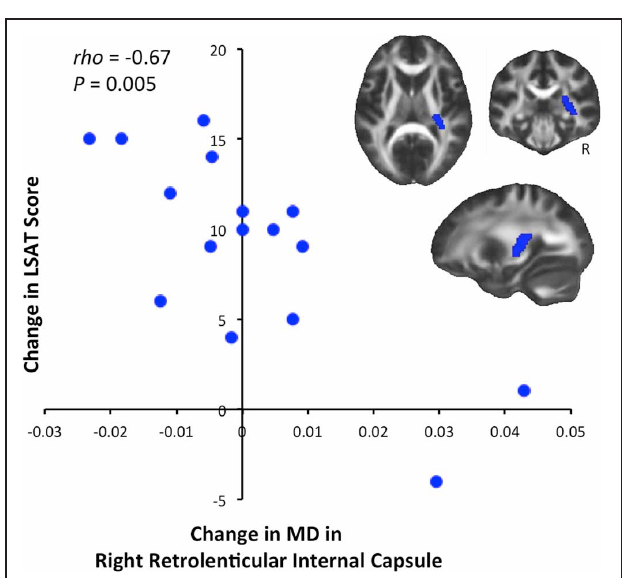
FIGURE 2 | Distribution of diffusion mode for whole-brain results. Histograms showing percentage of voxels with a given mode value were calculated for voxels that exhibited a significant training effect at the whole-brain level in RD (green) or MD (blue).